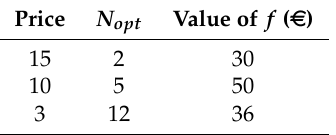
Table 2. Example pricing schemes for our dynamic pricing